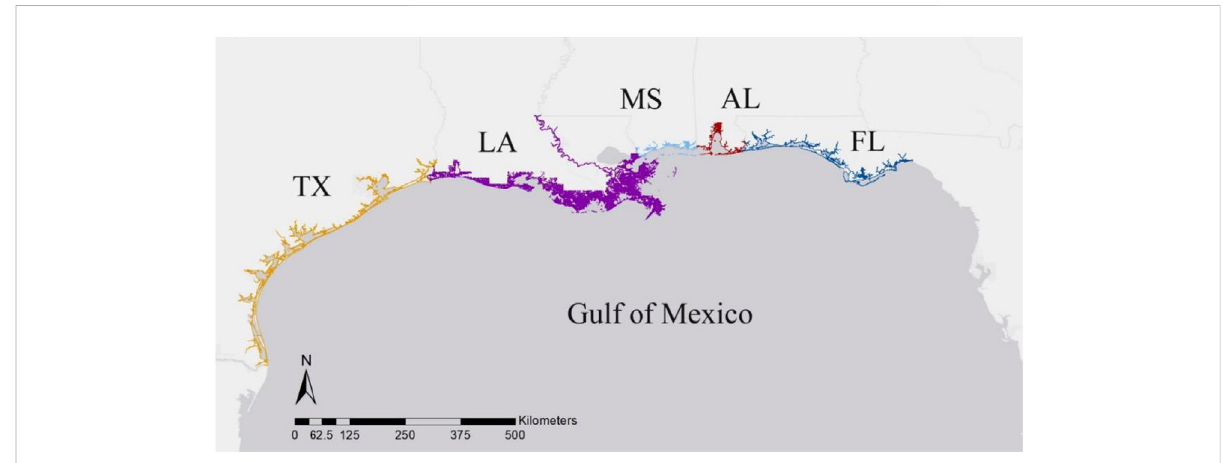
FIGURE 1 Linear coastline of each state in the northern Gulf of Mexico, where Texas = TX, Louisiana = LA, Mississippi = MS, Alabama = AL, and the Florida panhandle =